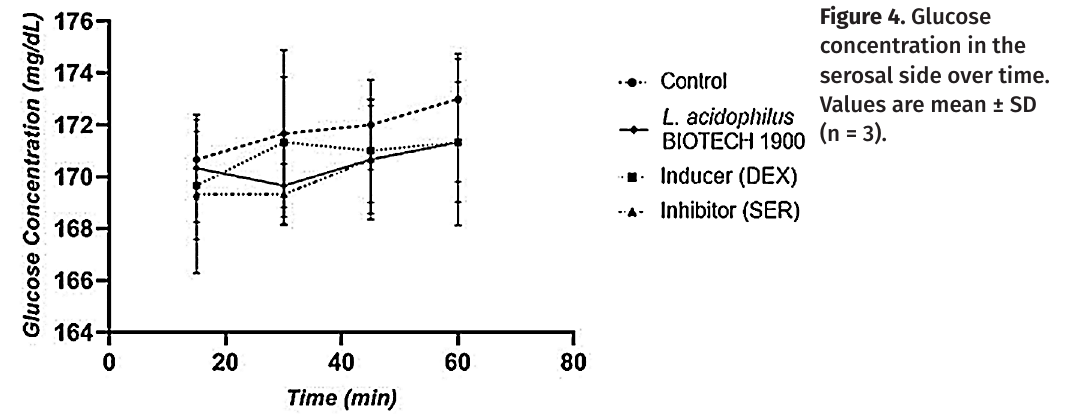
Figure 4. Glucose concentration in the serosal side over time. Values are mean ± SD (n =